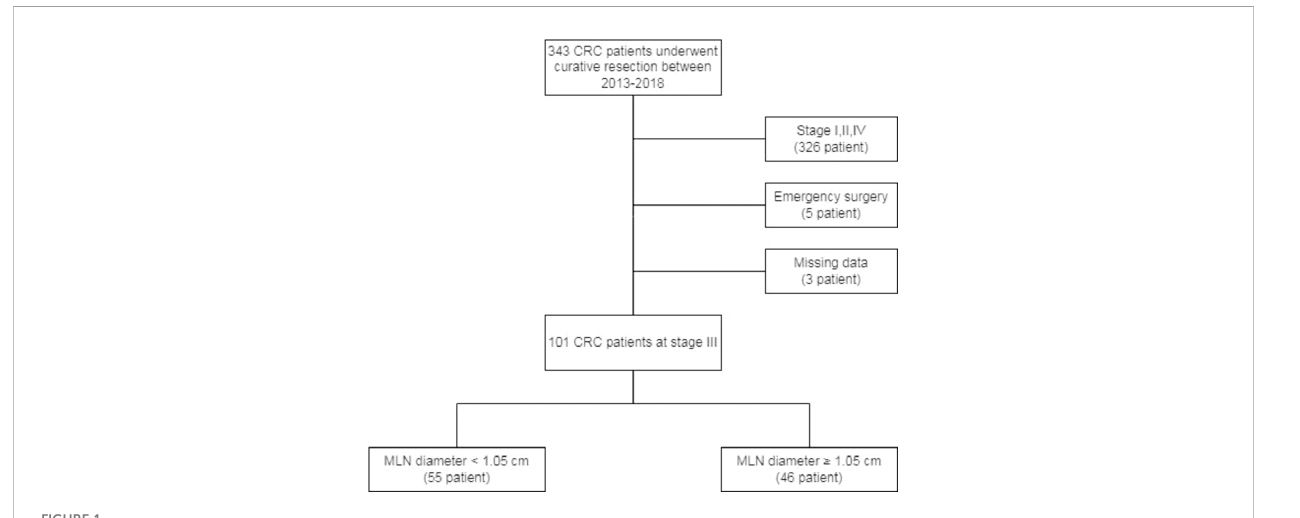
FIGURE 1 Flow chart of the study selection